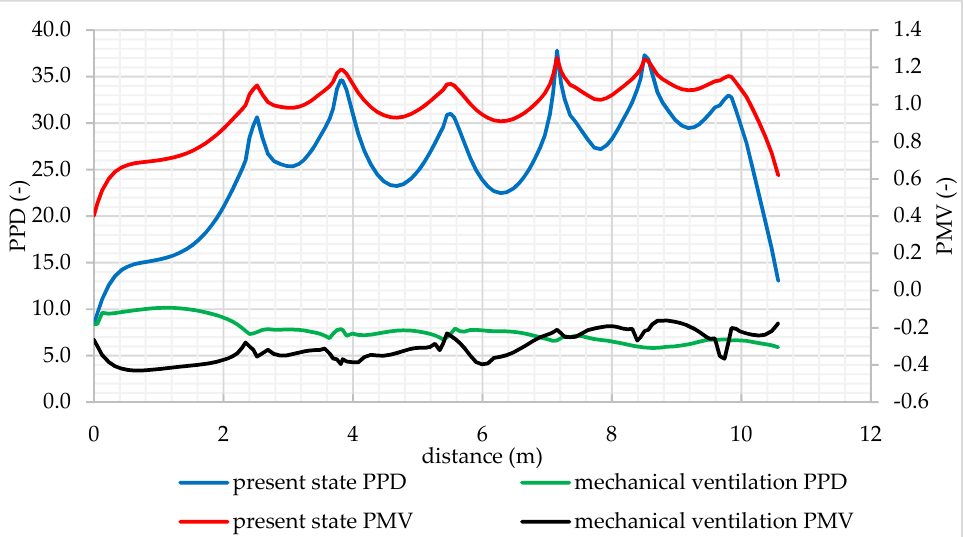
Figure 13. Distribution of the PPD and PMV coefficients between the external walls in the line of the T12/T4/T1 measuring sensors at the height of about 1.5 m; situation for the full room at 3:00 PM—the present state and the mechanical air conditioning.